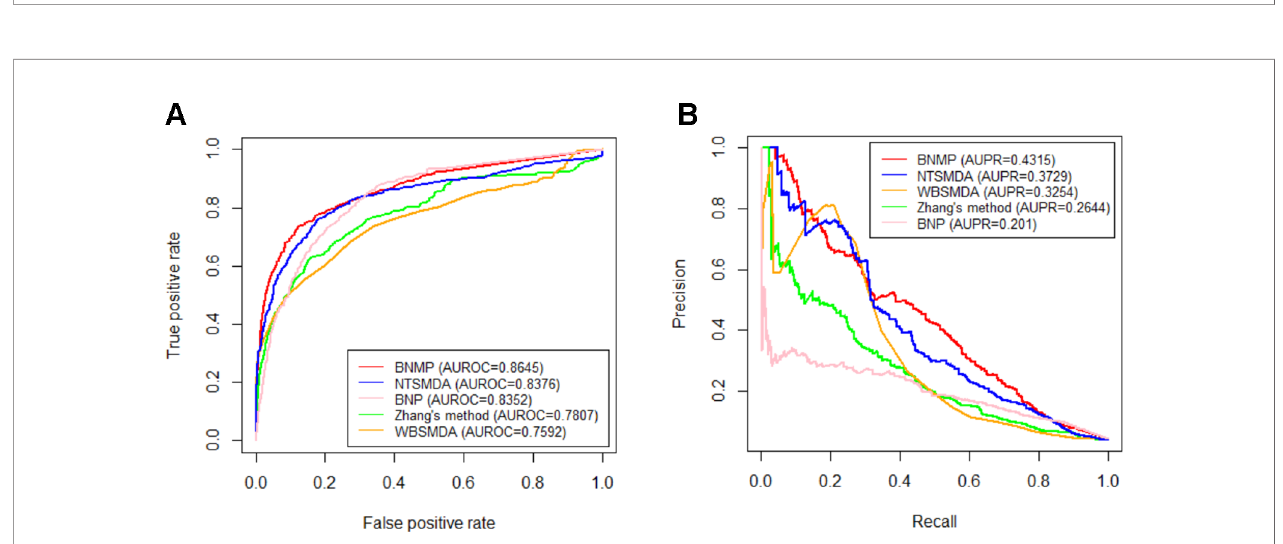
FIGURE 4 | Comparison of fi ve methods. (A) ROC curves. (B) PR curves.